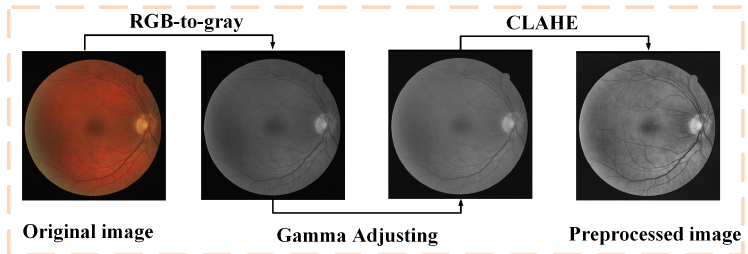
Figure 6. Details of the pre-processing